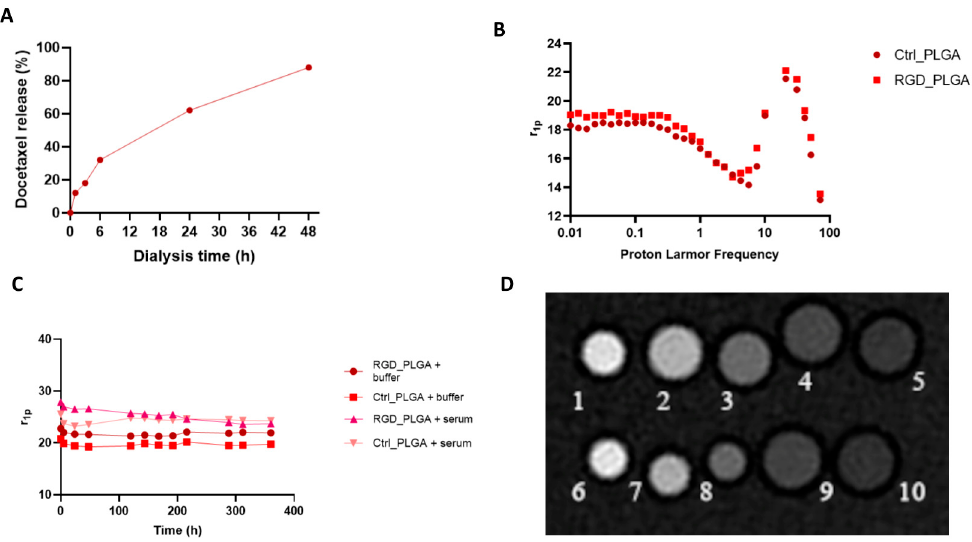
Figure 2. Chemo-physical characterization of PLGA nanoparticles. ( A ) In vitro release of Docetaxel. ( B ) NMRD profiles of Gd_PLGA-NPs. ( C ) Gd_PLGA-NPs’ molar relaxivities over time in HEPES/NaCl buffer and human serum for assessing PLGA stability over time. ( D ) Representative T 1w MR image of a phantom containing glass capillaries filled with variable concentrations of RGD_PLGA or Ctrl_PLGA (Legend: capillaries number 1–5 RGD_PLGA in PBS at variable concentrations, i.e., 1, 0.5, 0.2, 0.1, 0.05 mM; capillaries number 6–10 Ctrl_PLGA in PBS at variable concentrations, i.e., 1, 0.5, 0.2, 0.1, 0.05 mM).